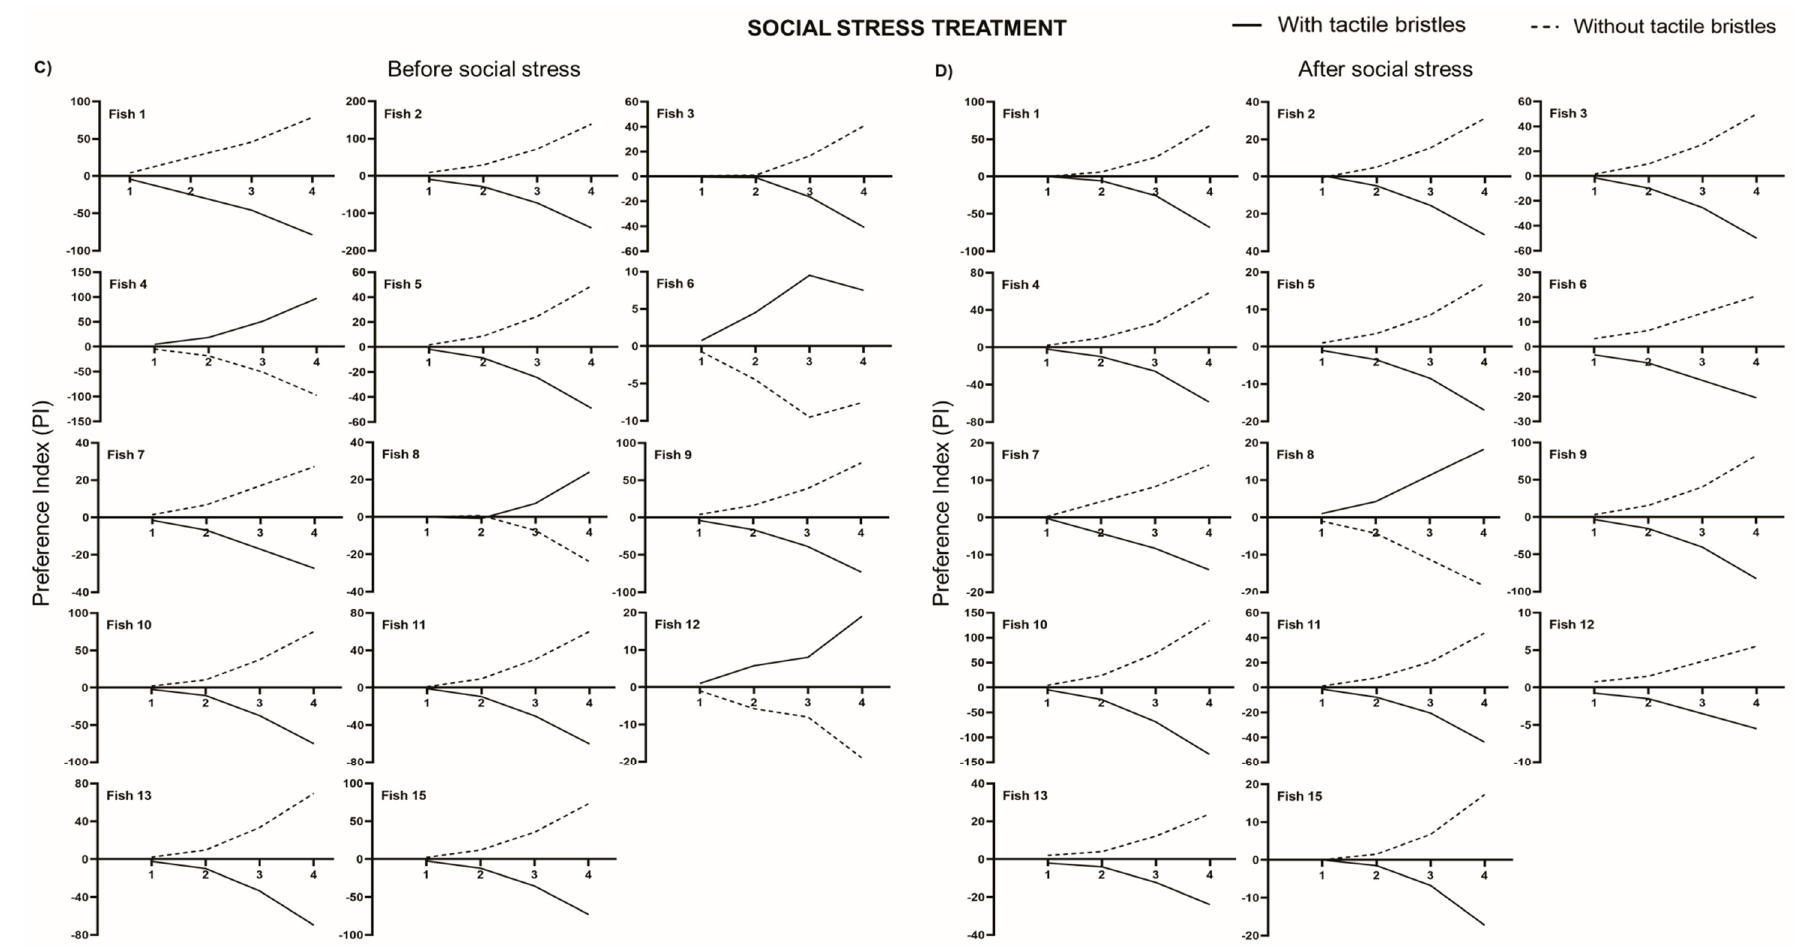
Figure 5. Preference index for the area with or without tactile bristles. Preference index of each fish from the isolation treatment ( A ) before and ( B ) after manipulation (isolation, n = 15); and from social stress treatment ( C ) before and ( D ) after manipulation (aggressive interaction, n = 14). We did not show fish 13 (isolation treatment), 14, and 16 (social stress treatment) in these analyses because they became motionless and did not cross through the tactile stimulator in one of the periods.